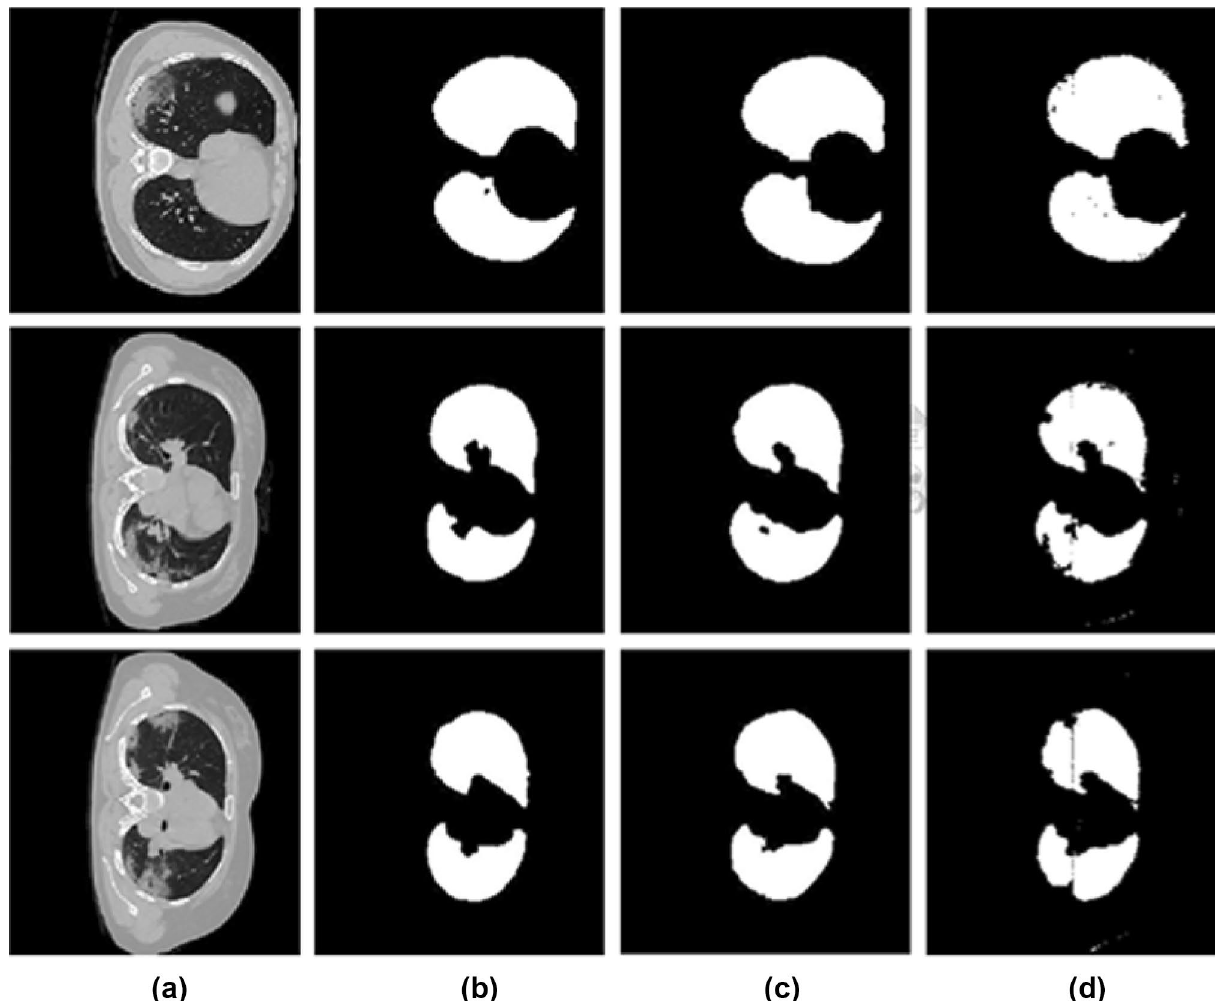
Figure 8. Comparison of Adam and Sgdm optimizer in lung parenchyma segmentation. ( a ) Input image slice, ( b ) ground truth, ( c ) output with Adam optimizer, ( d ) output with Sgdm optimizer.